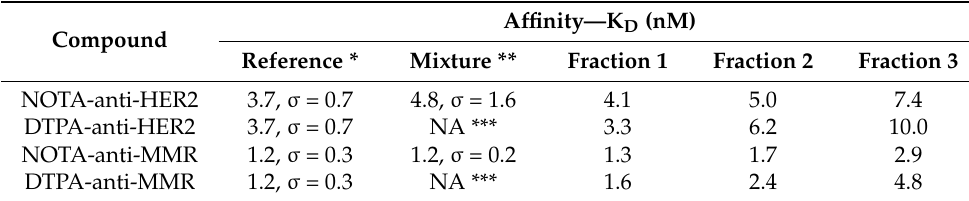
Table 1. Affinity measurement by SPR. Reference corresponds to the unconjugated sdAb; fractions 1, 2, and 3 refer to sdAb with 1, 2, and 3 conjugated chelators, respectively. Affinity—K D (nM) Compound Reference * Mixture **